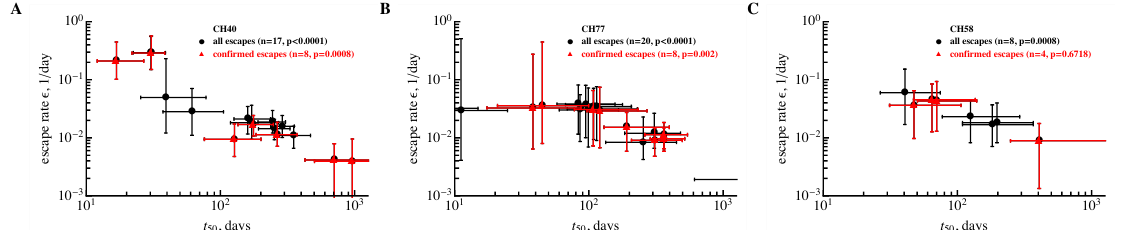
Figure 2. A sampling method which does not involve data modification still predicts a decline in the estimated escape rate with the time since infection. We used a novel approach of data sampling and estimated the rate of human immunodeficiency virus (HIV) escape from CD8 T cell responses for three Center for HIV/AIDS Vaccine Immunology (CHAVI) patients using previously published data [16,25]. Rates ( ε ) and time to 50% of the escape variant ( t 50 ) and associated errors are shown for three different patients in different panels (panel A : CH40, panel B : CH77, panel C : CH58); bullets indicate all escapes (in black) and triangles are for confirmed escapes (in red) [16]. Confirmed escapes were defined as fixed changes in HIV genome with a clear signature of viral escape with detected epitope-specific T cell response. Other escapes had a well-defined signature of escape but no epitope-specific T cell response was detected [16]. Resulting p values from the Spearman rank correlation test are indicated on individual panels. Panel ( B ) does not show an estimate for one escape due to very low escape rate ε and long t 50 .